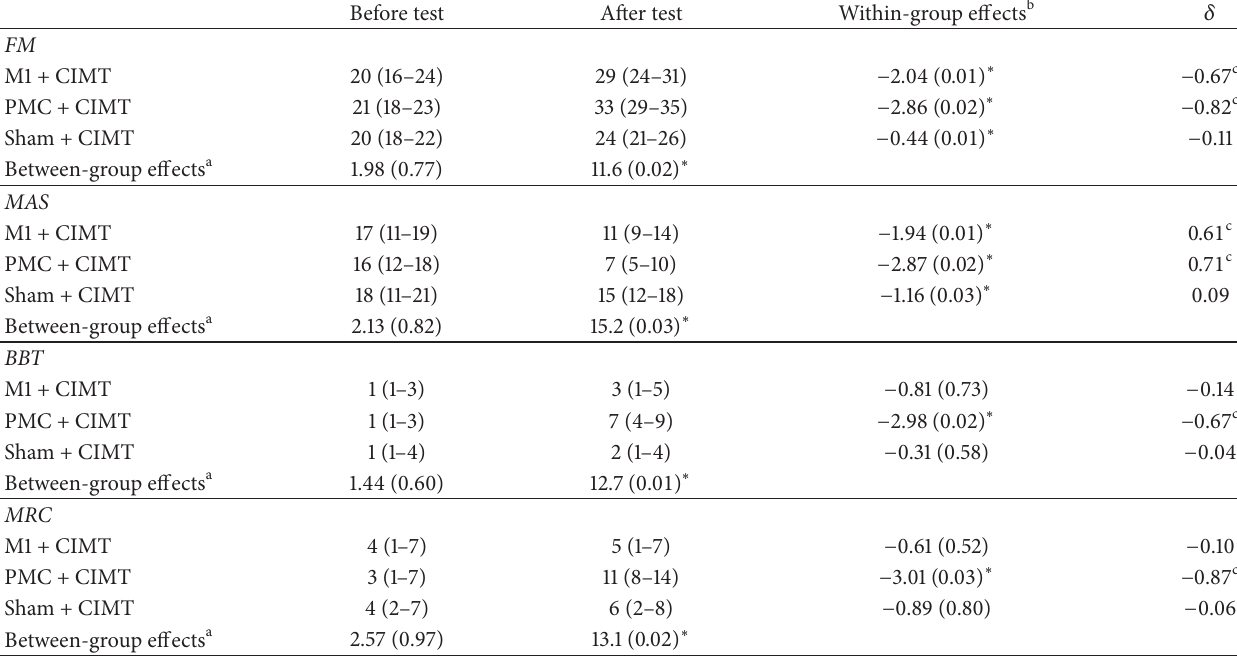
Table 2: Descriptive and inferential statistics of the secondary outcomes